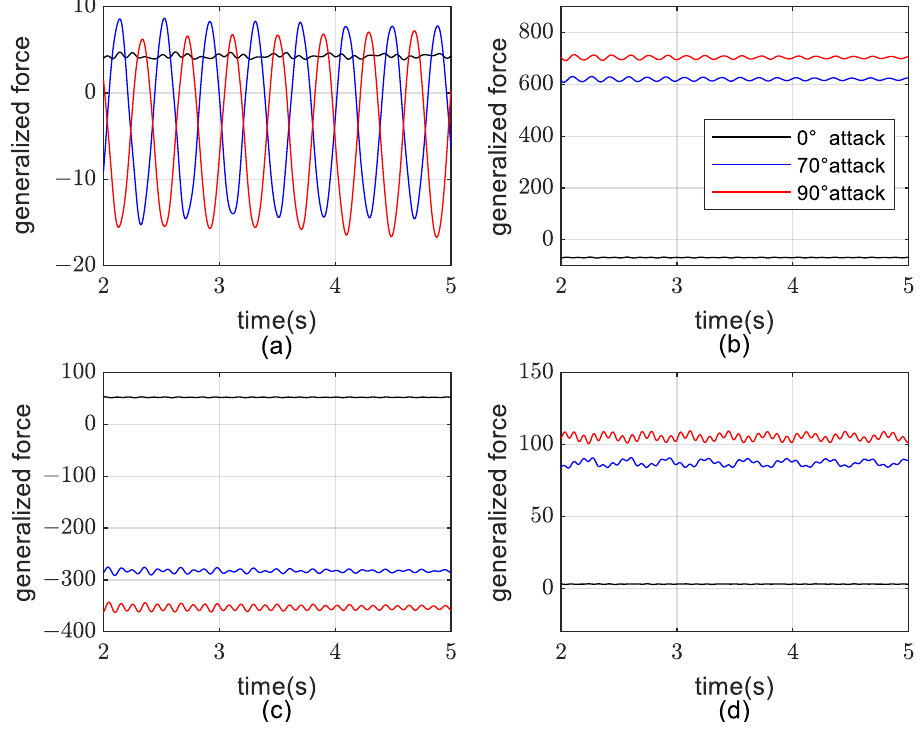
Figure 13. Curves of the generalized force–time response ( Ma = 0.6, p = 1000 Pa). ( a ) First-order mode, ( b ) second-order mode, ( c ) third-order mode, and ( d ) fourth-order mode.